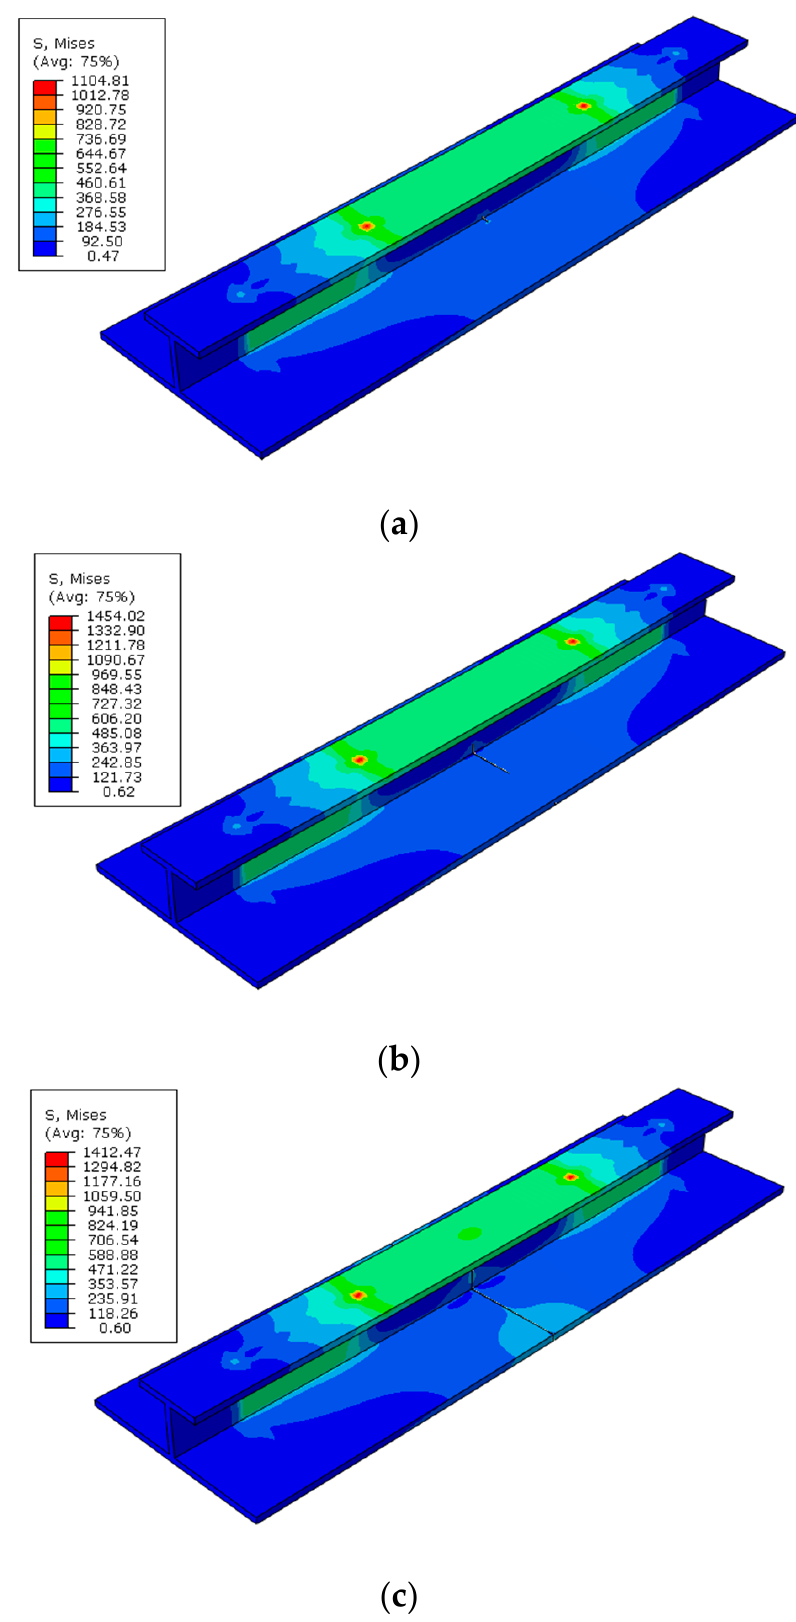
Figure 14. Stress contour plots for bending model; S is the displacement load under each state after conversion; ( a ) S = 0.88 mm; ( b ) S = 3.310 mm; ( c ) S = 3.365 mm. (Unit: MPa.)